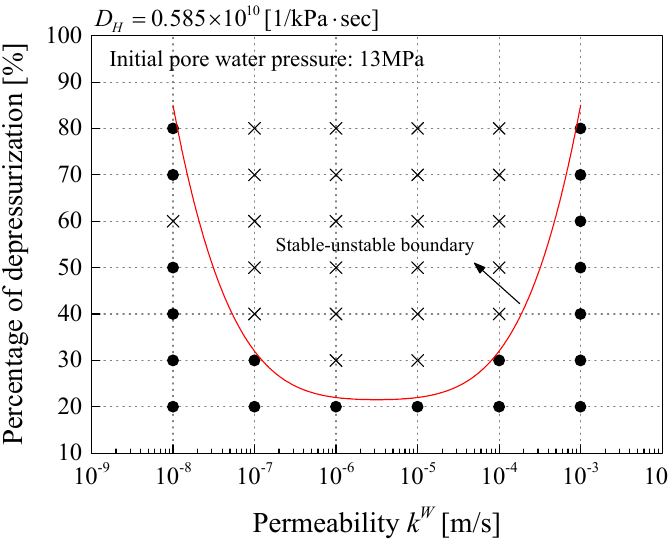
Figure 7. Stable and unstable regions of permeability and the depressurization level during the MH dissociation